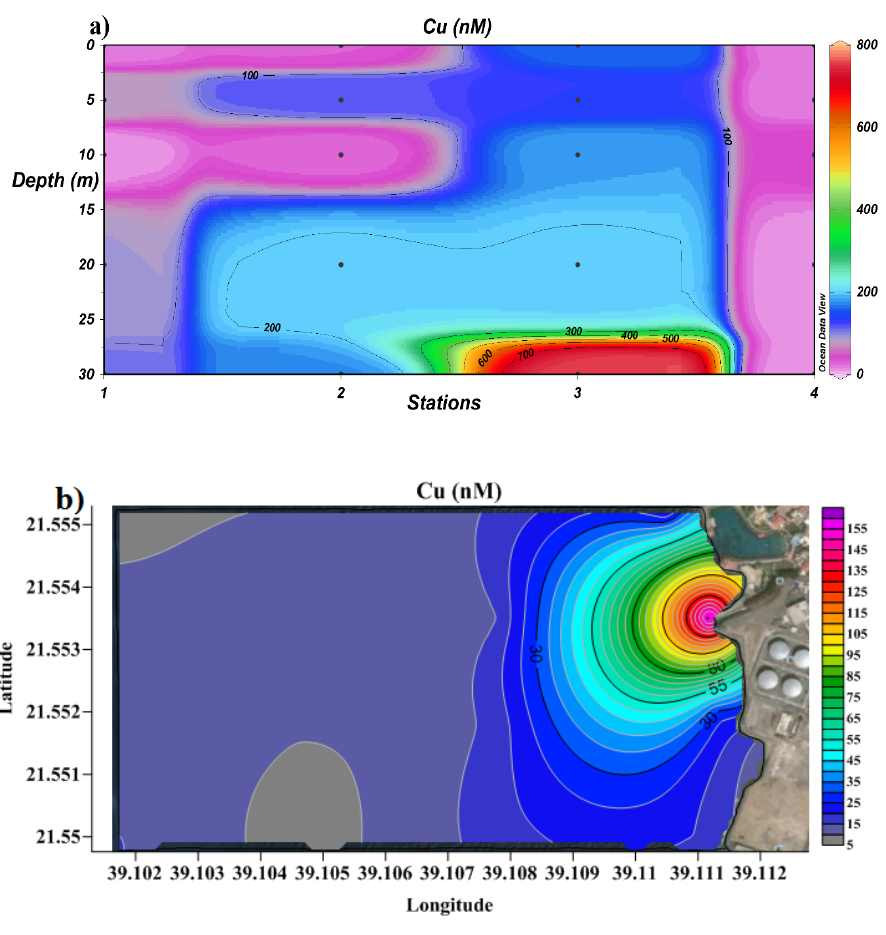
Figure 6: Cross-section profile (a) and surface distribution (b) of dissolved Cu.